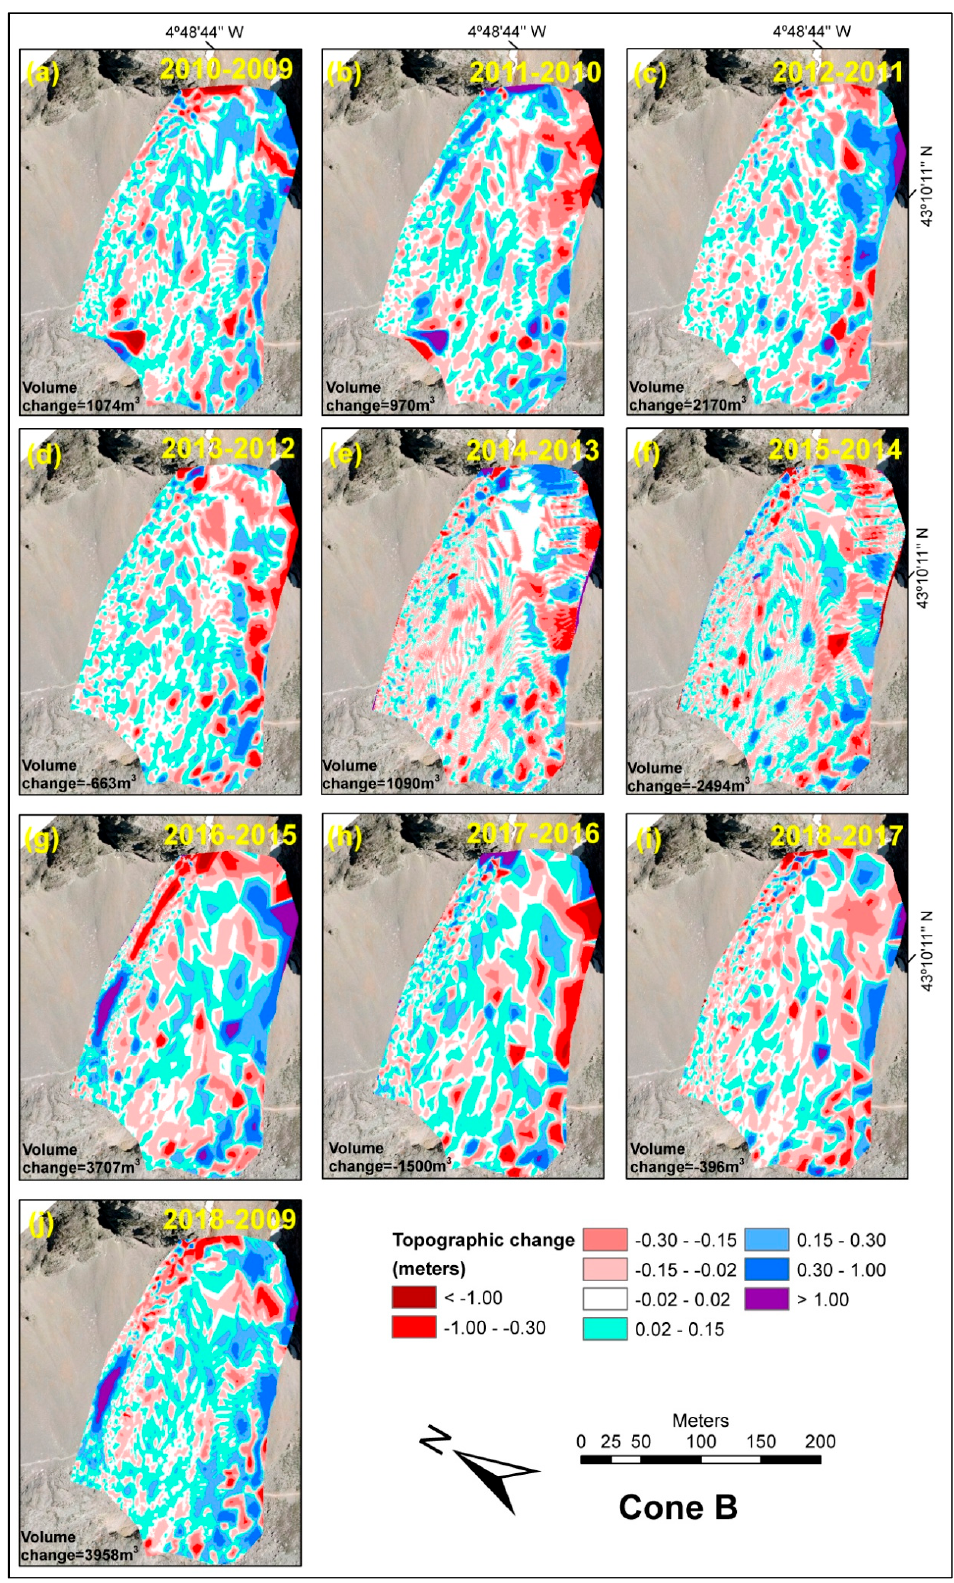
Figure 14. Annual differences (a–i) and total (j) difference (2018–2009) in volumes in Cone B.